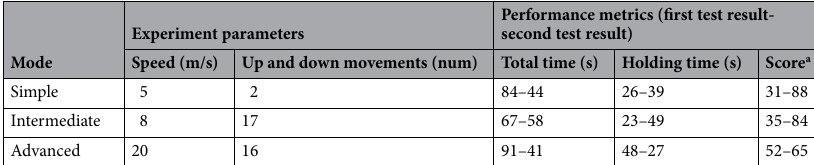
Table 3. Rehabilitation game exercise results. a Score is calculated with the following formula: ( holdingtime / totaltime ) × 100